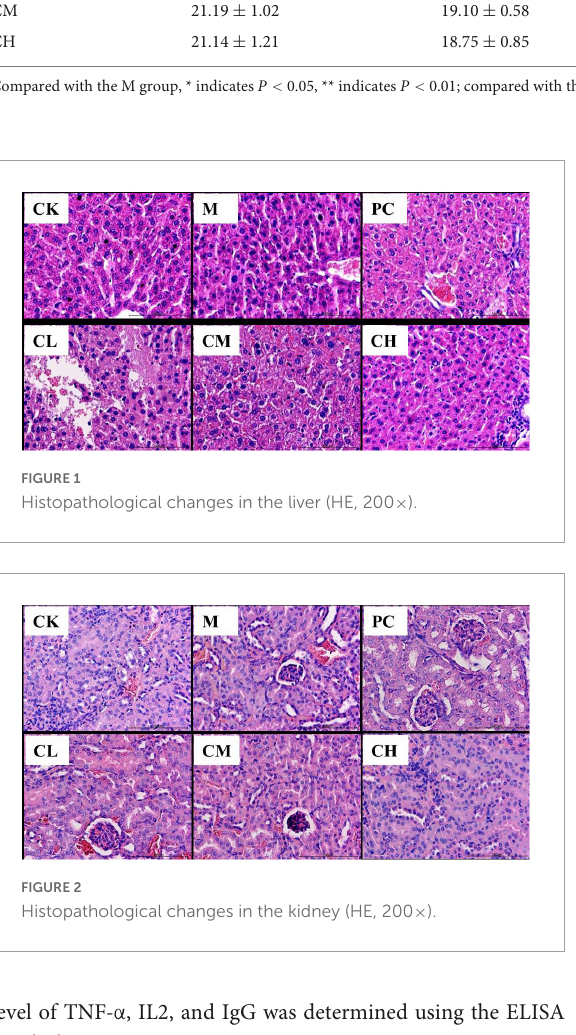
level of TNF- α , IL2, and IgG was determined using the ELISA kits